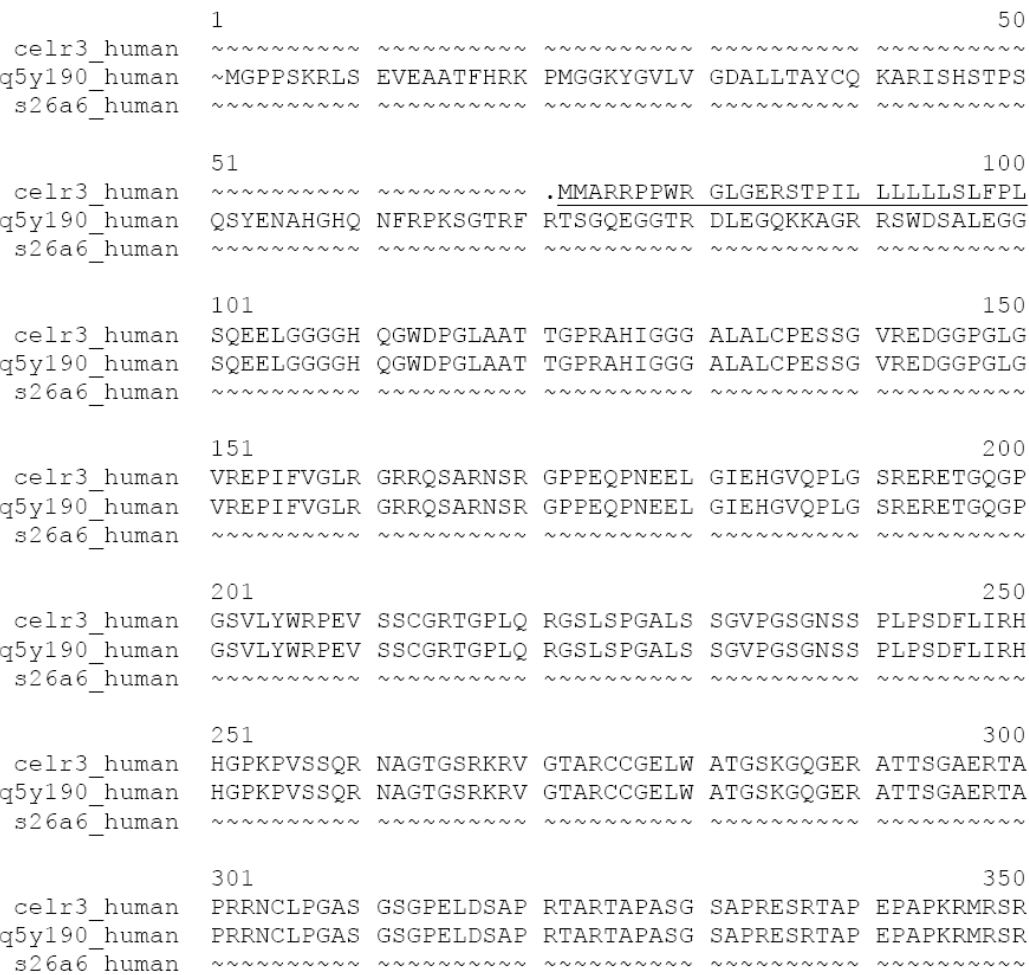
Figure S1. Alignment of the fusion product (q5y190_human) with the products of the distinct tandem genes for celr3_human and s26a6_human found on chromosome 3. Note that the fusion protein lacks a cleavable signal peptide characteristic of a type I transmembrane protein (the signal peptide of celr3_human is